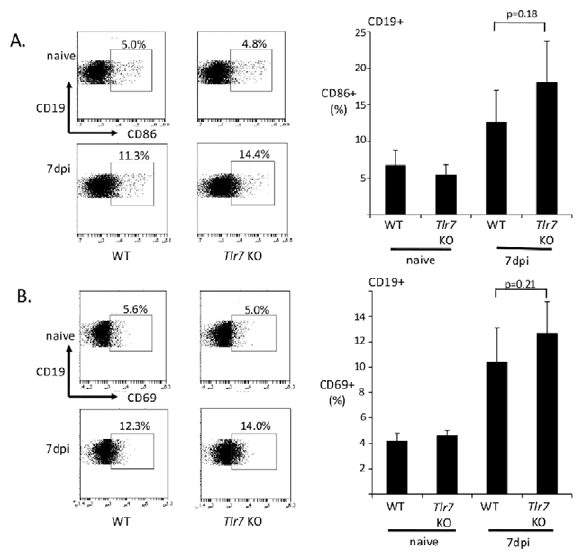
Figure 5. B cells upregulate CD86 and CD69 independently of TLR7. Wild-type (WT) or TLR7-deficient mice were infected with FV. At 7 dpi, splenocytes were harvested and the levels of CD86 ( A ) and CD69 ( B ) expression determined for B cells (CD19 + ) by flow cytometry. A representative flow cytometry plot for the CD19 + gated cells for each group is shown. Each bar of the histogram represents the average of 5– 6 mice. Control ‘naı¨ve’ mice were inoculated with an equivalent dose of spleen homogenate without FV.